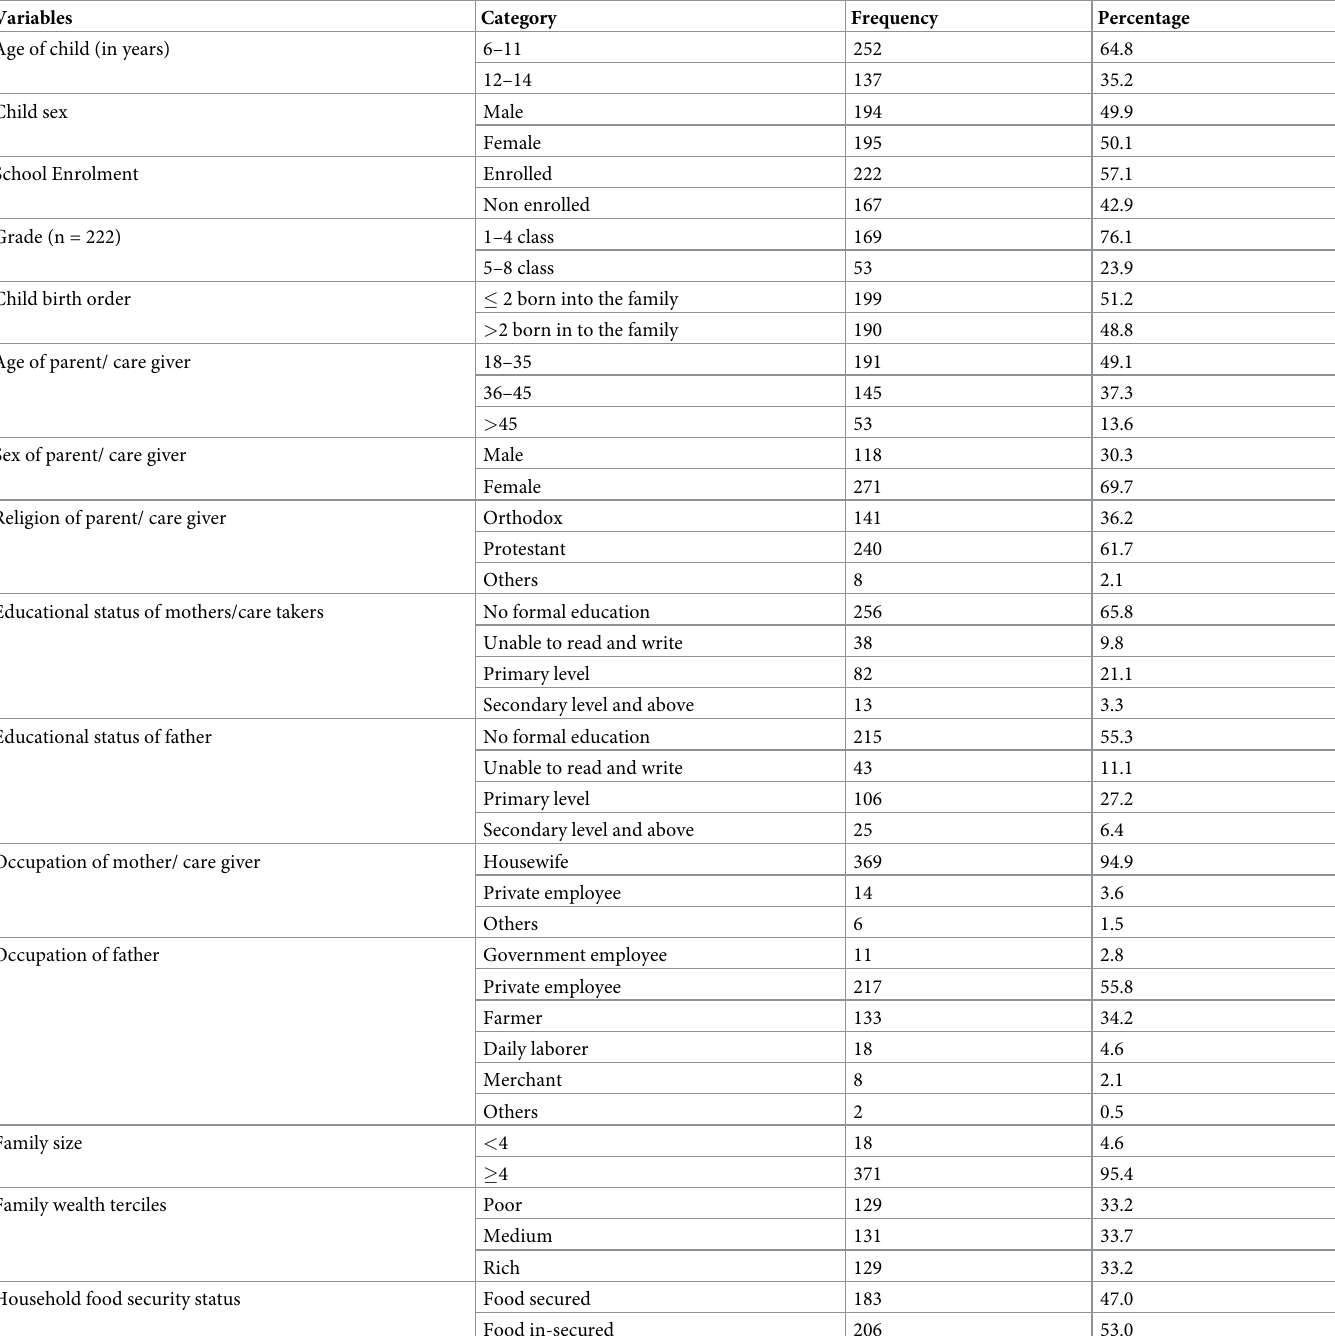
Table 1. Socio-demographic and economic characteristics of study participants (n = 389), Arba Minch HDSS, Southern Ethiopia, April to May